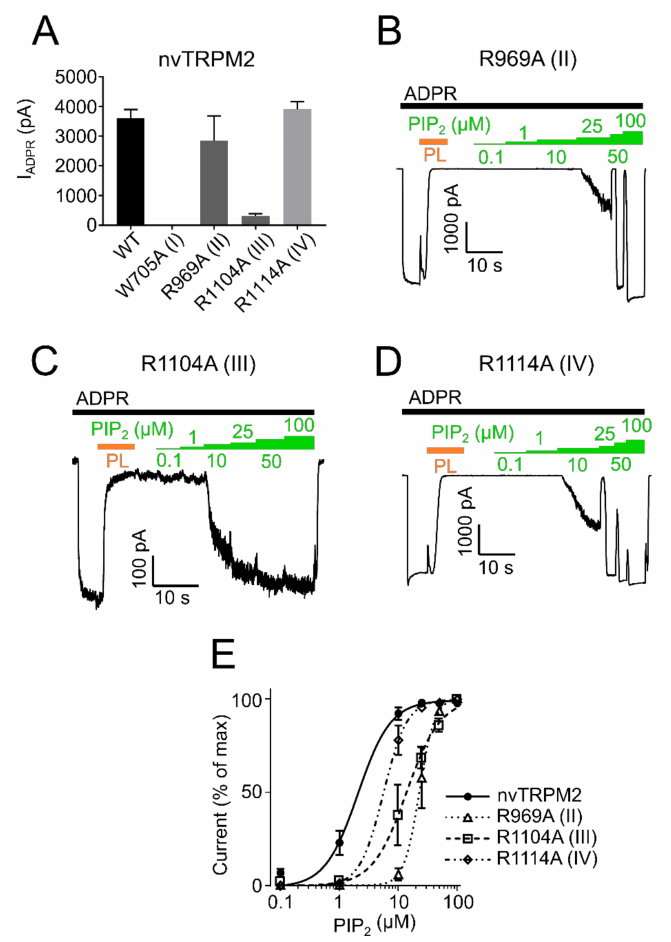
Figure 8. PIP 2 sensitivity of nvTRPM2 membrane interfacial cavity mutant channels. ( A ) Current amplitudes induced by ADPR (100 µ M, black bar) of wild-type and mutant nvTRPM2 channels. PIP 2 (green bars) dose-response recordings of nvTRPM2 R969A (II) ( B ), R1104A (III) ( C ) and R1114A (IV) ( D ) in presence of 100 µ M ADPR (black bar). Since maximum currents were already observed in absence of external PIP 2 , natural PIP 2 was scavenged via polylysine (15 µ g/mL, PL, orange bar) and subsequently restored via increasing PIP 2 concentrations. ( E ) Data summary of PIP 2 sensitivity of mutants R969A (II), R1104A (III), and R1114A (IV) showing dominant right shift compared with wild-type nvTRPM2. Data represented as mean ± SEM; n =